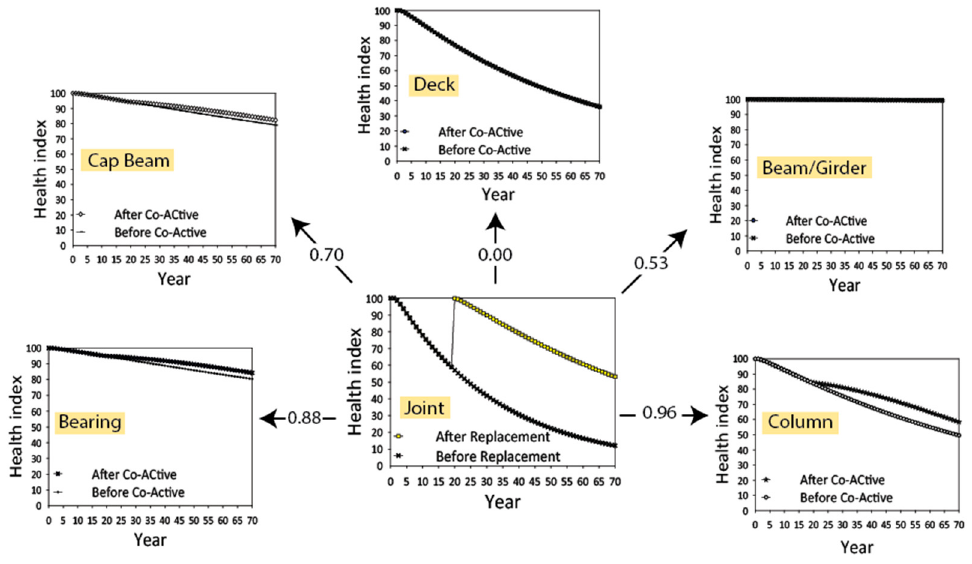
Figure 5. Flowchart showing how one element’s HI change affects a time-history of other elements.